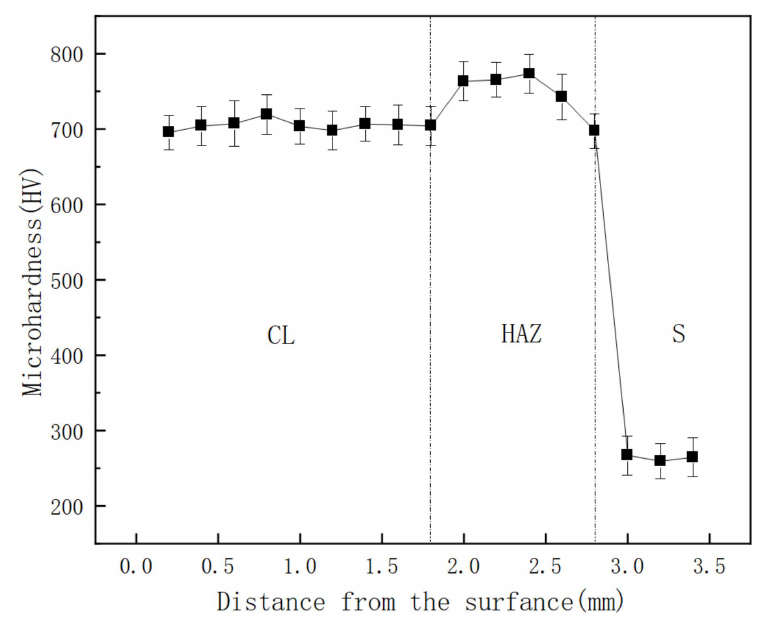
Figure 6. Hardness distribution of Ni35 + 20% SiC + 20% Ni/MoS 2 cladding